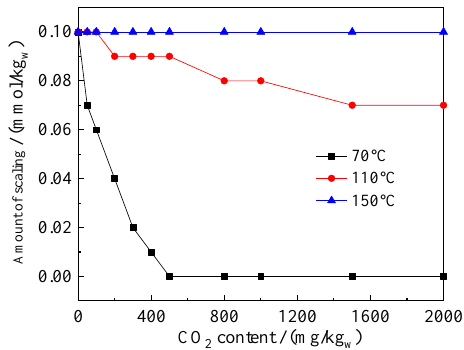
Figure 6. Relation of scale quantities with CO 2 content under different well fluid temperatures.